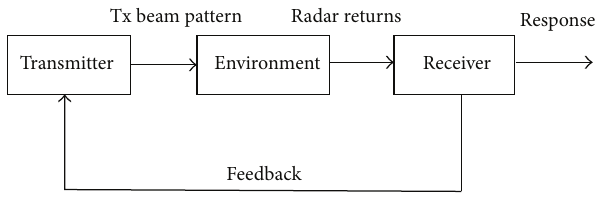
Figure 1: Basic cognitive cycle.